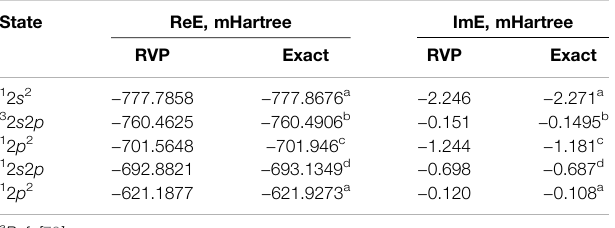
TABLE 1| Multiplecomplexenergies ofthedoubly-excitedHe**Feshbachstates; RVP vs. exact values. These values are also represented graphically in Figure 5 . Reprinted (adapted) with permission Ref. [50]. Copyright (2019) American Chemical Society.